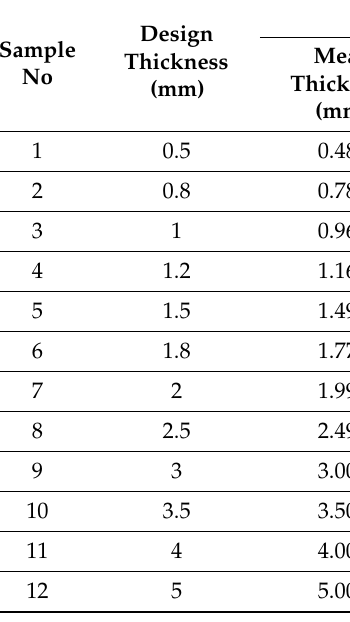
(b) Figure 7. ( a ) Fitted line plot for a regression model. Sample thickness and % error in the thickness of developed samples decrease exponentially with increasing thickness. ( b ) Prediction plot showing the values falls within the 95% prediction interval. The central red line is fitted line, and the outer blue lines represent 95% prediction interval. 3.4. Distortion Analysis The final quality of part depends on the material characteristics and production process parameters. The part deflection or distortion is a result of a combination of these factors. The residual stresses in a developed part cause the distortion. The distortion is measured by measuring the displacement using a dial indicator on a flatbed at ten points on each sample in as ‐ built condition, and the results are shown in Table 4.